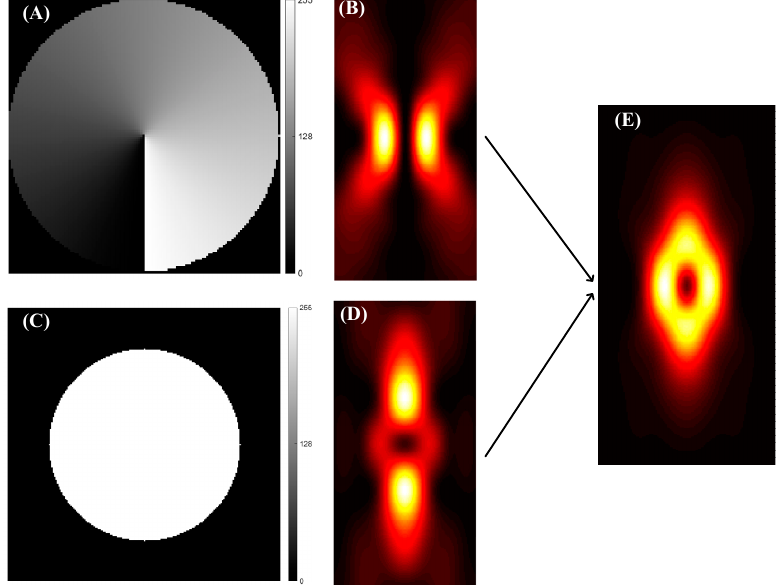
Figure 2 . 3D vortex generation process. ( A ) The vortex pattern used for generating transverse vortex PSF, ( B ) The intensity distribution cross-section of a vortex PSF, ( C ) The hollow pattern used for hollow PSF, ( D ) The intensity distribution cross-section of a hollow PSF, ( E ) The intensity distribution cross-section of 3D negative PSF.